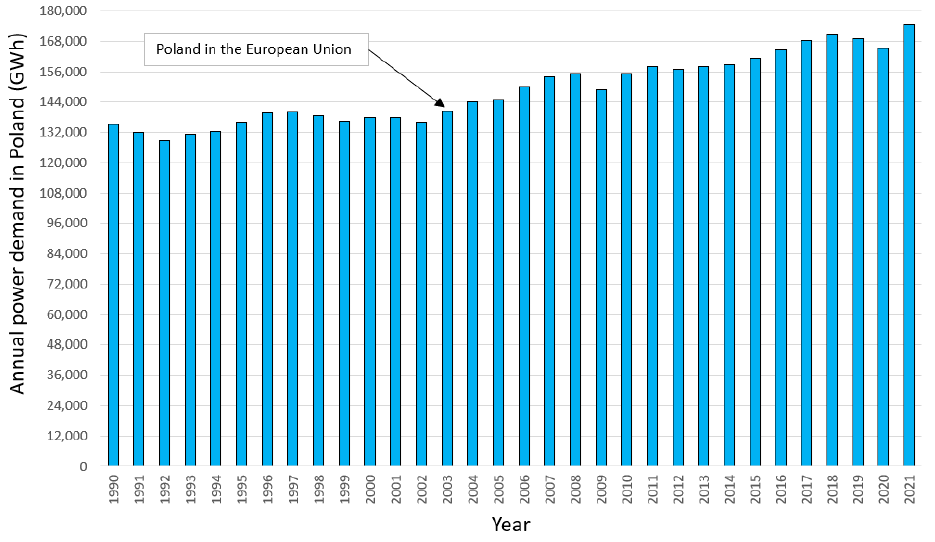
Figure 1. Historical data for annual power demand in Poland.